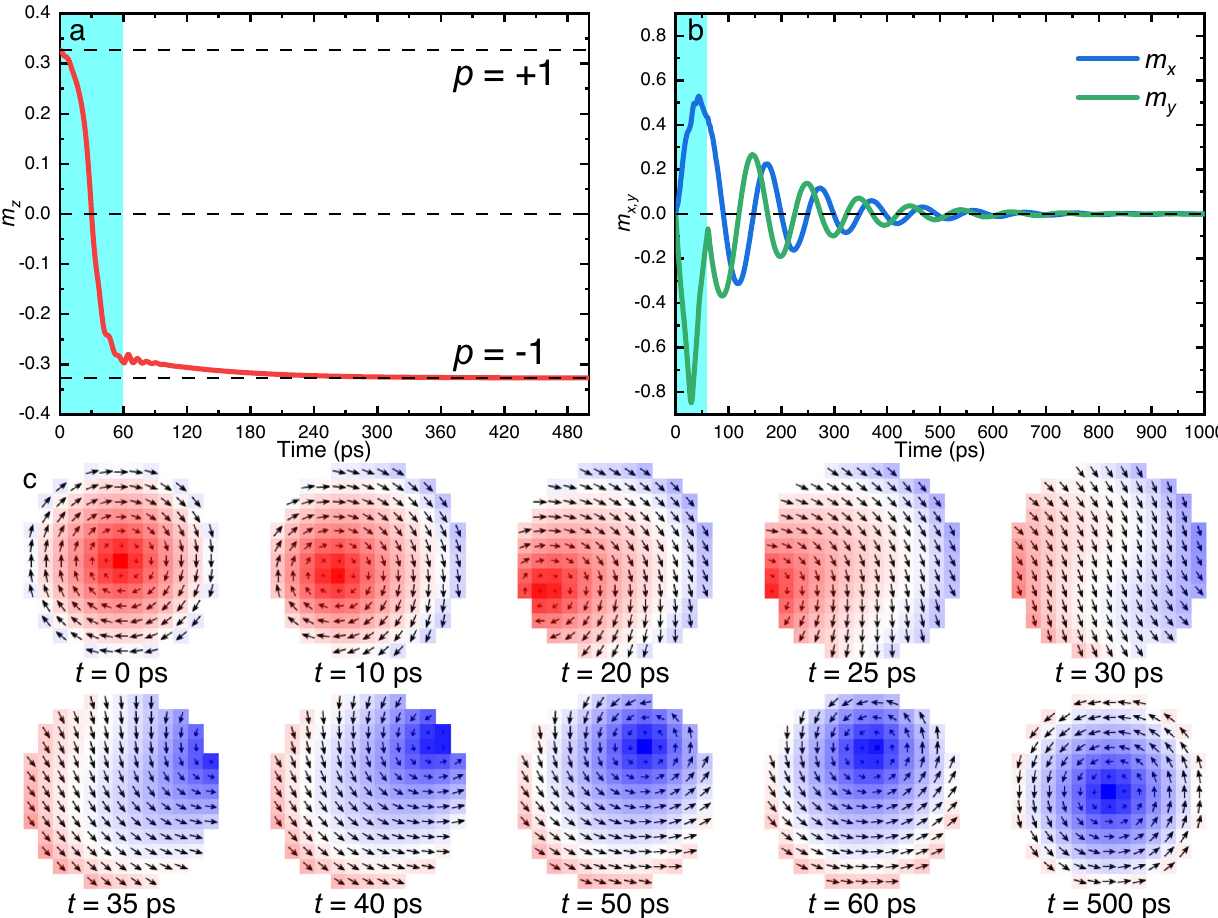
Fig. 4 The switching of the polarity of a meron induced by an in-plane magnetic fi eld pulse. a The out-of-plane component of the reduced magnetization m z as a function of time. The initial state is a meron ( p = 1) relaxed in the disk with 13 spins in the diameter (i.e., the radius of the meron is n = 7). The in- plane magnetic fi eld of H x = 400mT is applied for 60 ps (indicated by the cyan area), followed by the relaxation until t = 1000ps. The meron is switched to the state with p = − 1 after the application of the in-plane fi eld. b The in-plane components of the reduced magnetization m x and m y as functions of time. c Selected top-view snapshots showing the spin con fi guration in the nanodisk during the fi eld-induced switching of the meron polarity. The simulation parameters are given in the caption of Fig. 2. More details are given in the “ Methods ”